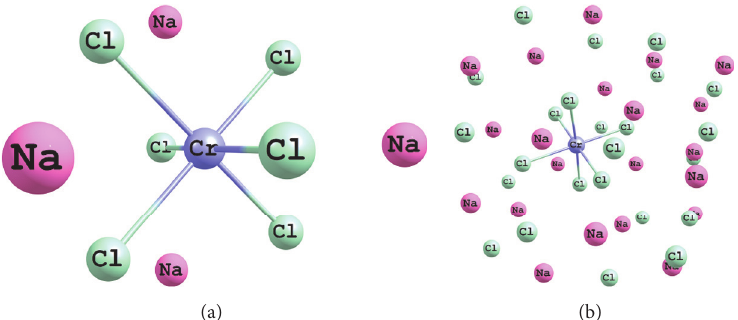
Figure 2: Optimized structures of (a) 4Na + ⋅ [CrCl 6 ] 3− and (b) Na 3 CrCl 6 + 18NaCl.